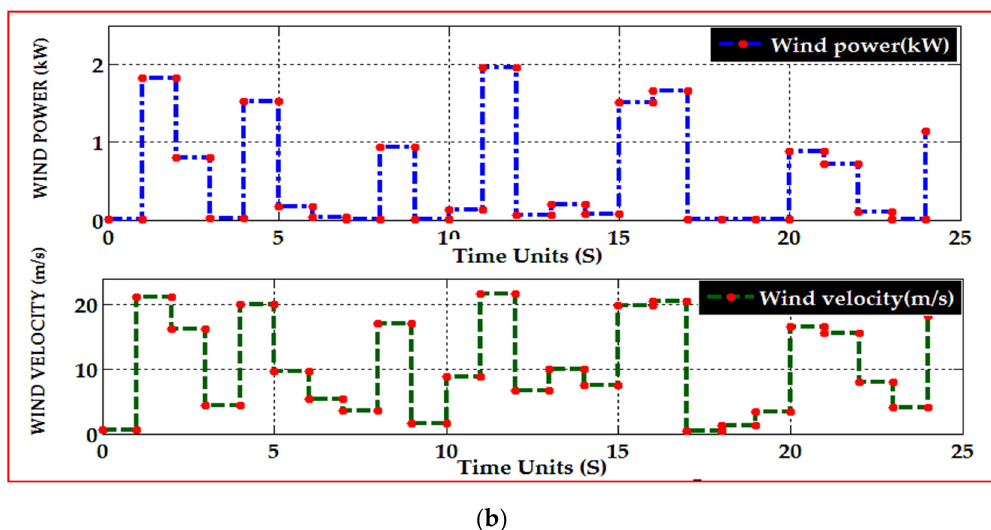
Figure 3. Performance of the Virtual VAWT model ( a ) Virtual Simulink model for VAWT. ( b ) Simulation of power output with wind velocity variations for a VAWT model .